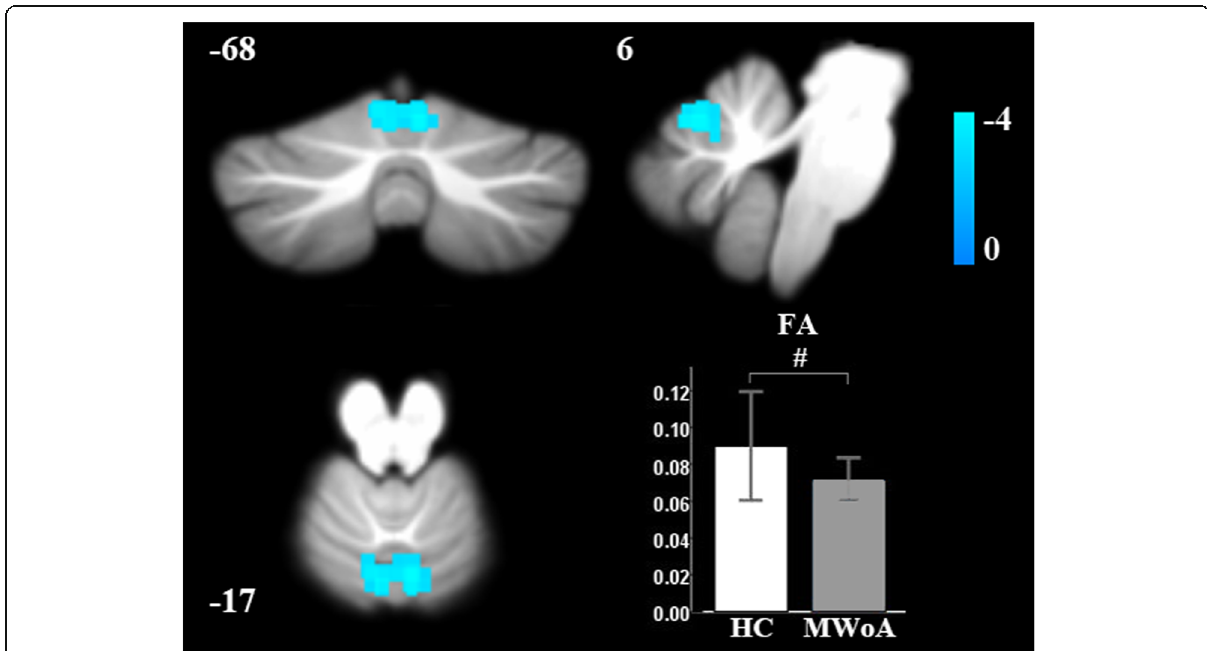
Fig. 1 Brain regions with significantly decreased fractional anisotropy (FA) of MWoAs relative to healthy controls. # Statistical significance of p<0.001 at the voxel level, FWE-corrected p<0.05 at the cluster level.